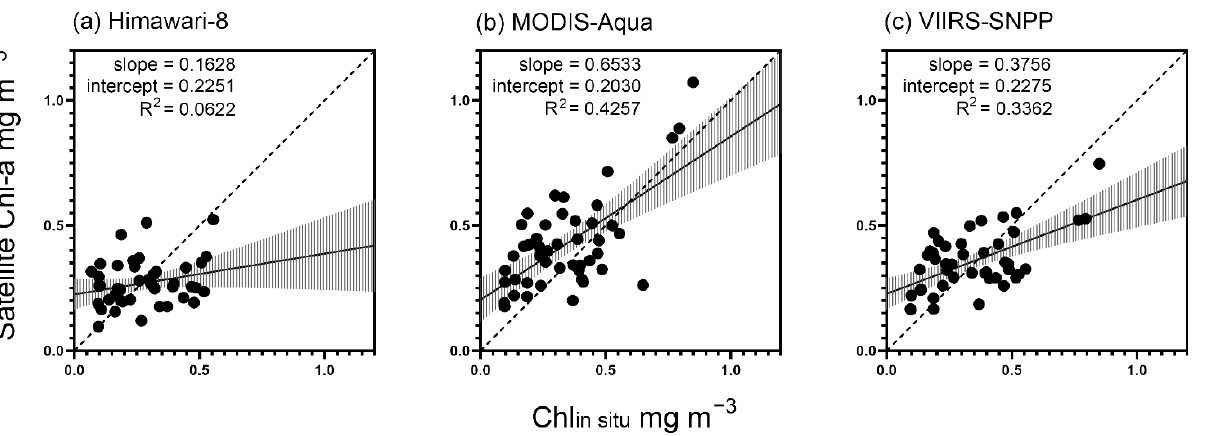
Figure 4. Fitting results of original remote sensing Chl products and Chl in situ data. ( a ) Himawari-8, ( b ) MODIS-Aqua, ( c ) VIIRS-SNPP. The points are the matched data, the solid line is the slope of each sensor, and the dashed line represents 1:1. The shaded areas show the 95% confidence interval range.